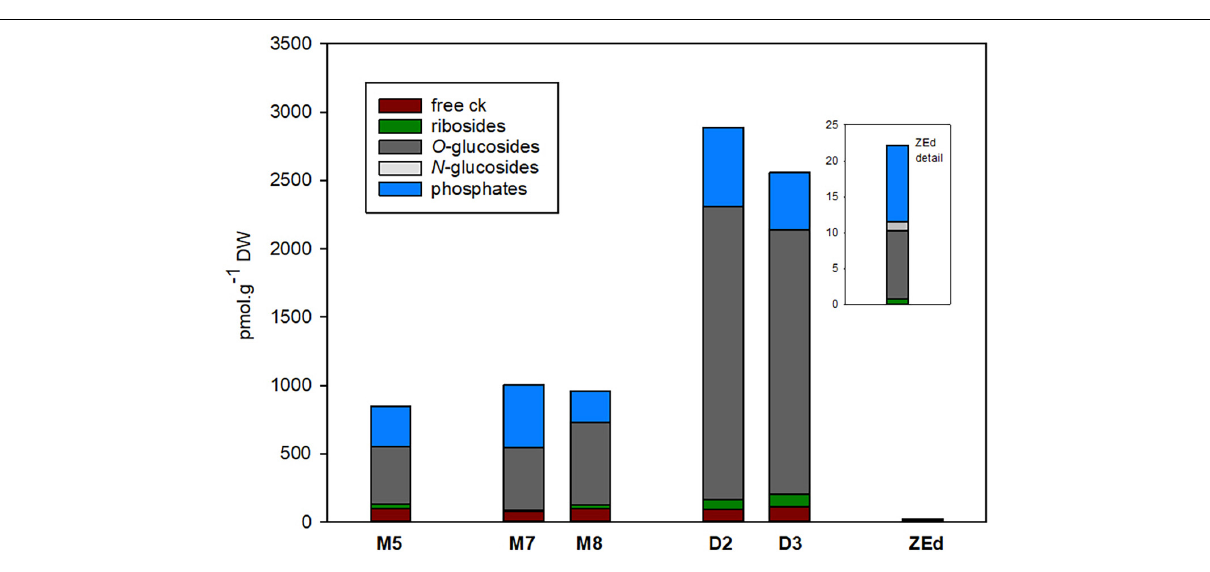
step and fluctuated near 200 pmol/g DW in both M5 and desiccated